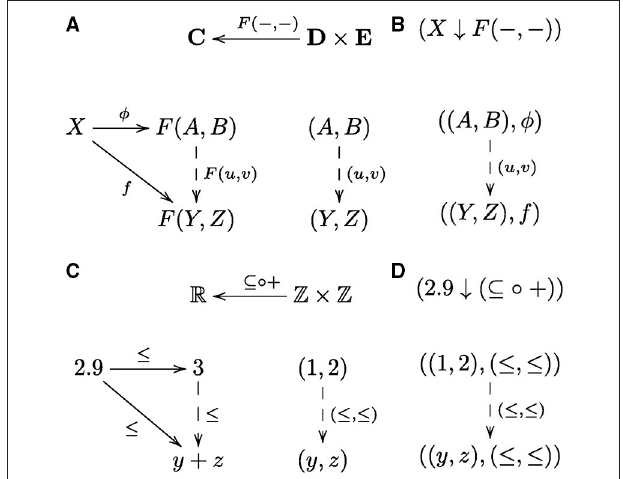
FIGURE 6 | Universal construction and comma category. (A) Universal arrow from object X to bifunctor F ( − , − ) and (B) corresponding comma category (bifunctor). (C) The universal arrow from the object (point) 2.9 to the composition of the addition function/functor with the inclusion function/functor and (D) corresponding comma